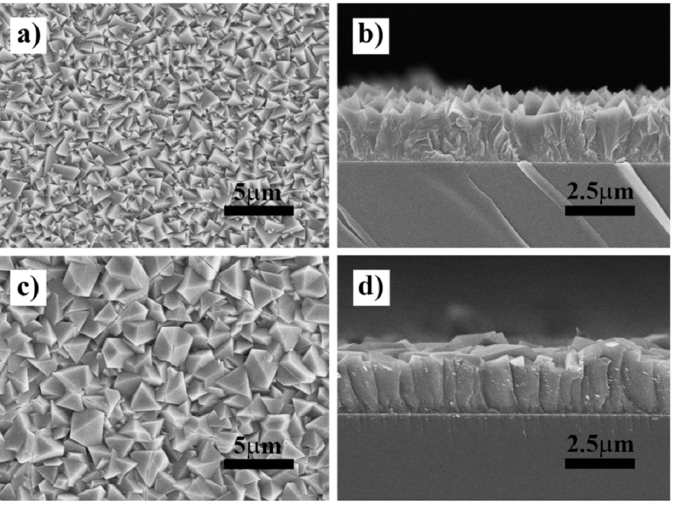
Figure 19. SEM images of CPM-5 ⊃ Tb 3+ ( a , b ) and MIL-100(In) ⊃ Tb 3+ ( c , d ) films. Reprinted with permission from Reference [94]. Copyright 2014 the American Chemical Society (Washington, DC, USA).